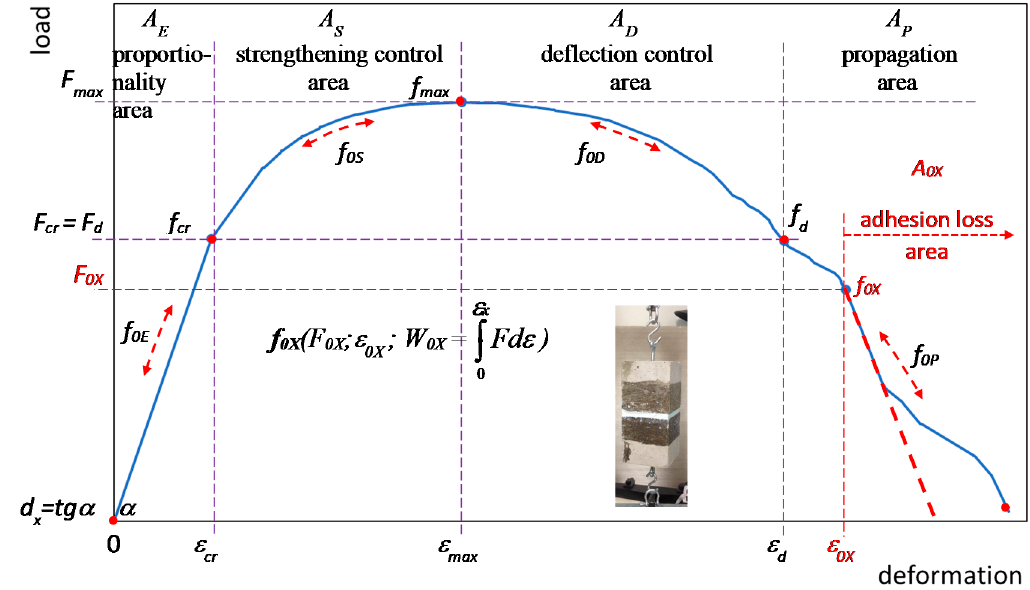
Figure 7. A diagram for the assessment of mechanical properties based on the load–deformation curve of ESD pseudoplastic materials in an axial tensile test.